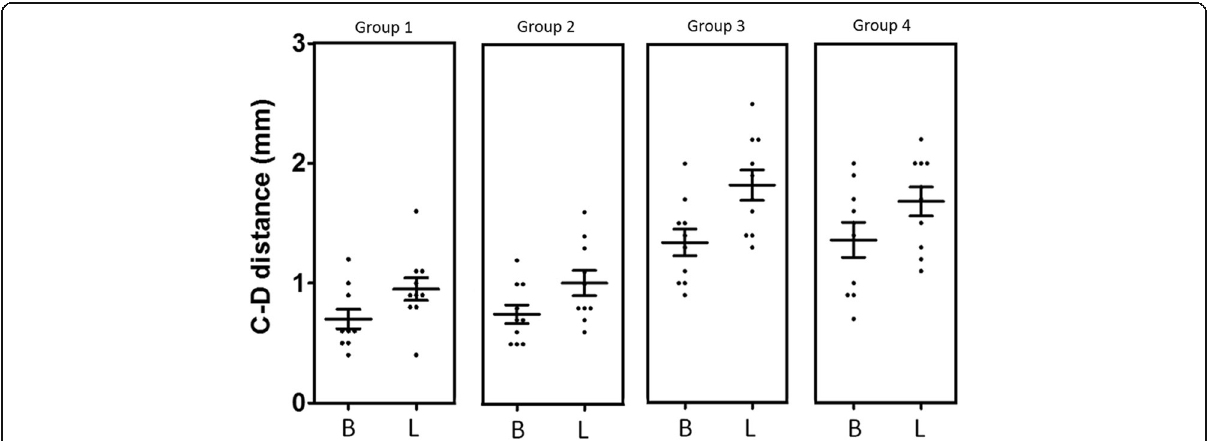
Fig. 6 Graph comparing the data of buccal (B) and lingual (L) measured the C-D distance (tissue thickness). Group 1 = implant installed in fresh extraction and submerged; group 2 = implants in fresh extraction and immediately exposed; group 3 = implants installed in healed site and submerged; and group 4 = implants in healed site and immediately